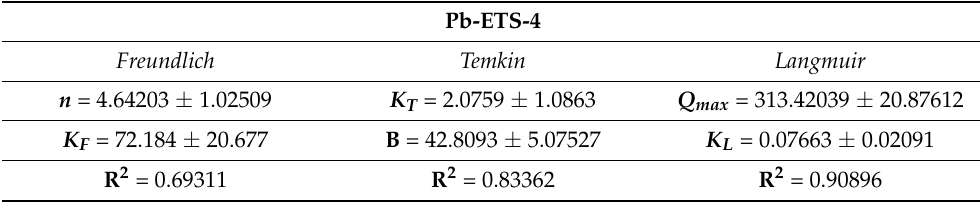
Table 2. Freundlich, Temkin, and Langmuir adsorption isotherm